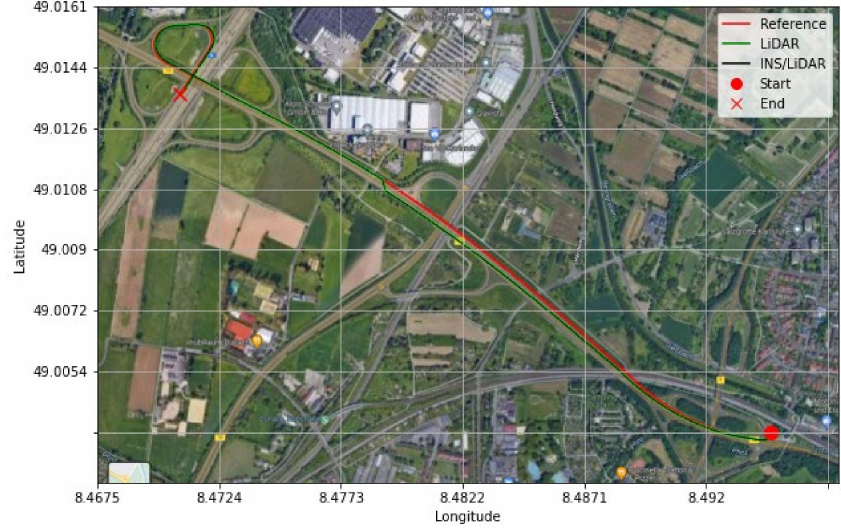
Figure 26. D-42—GNNS-assisted: comparison of